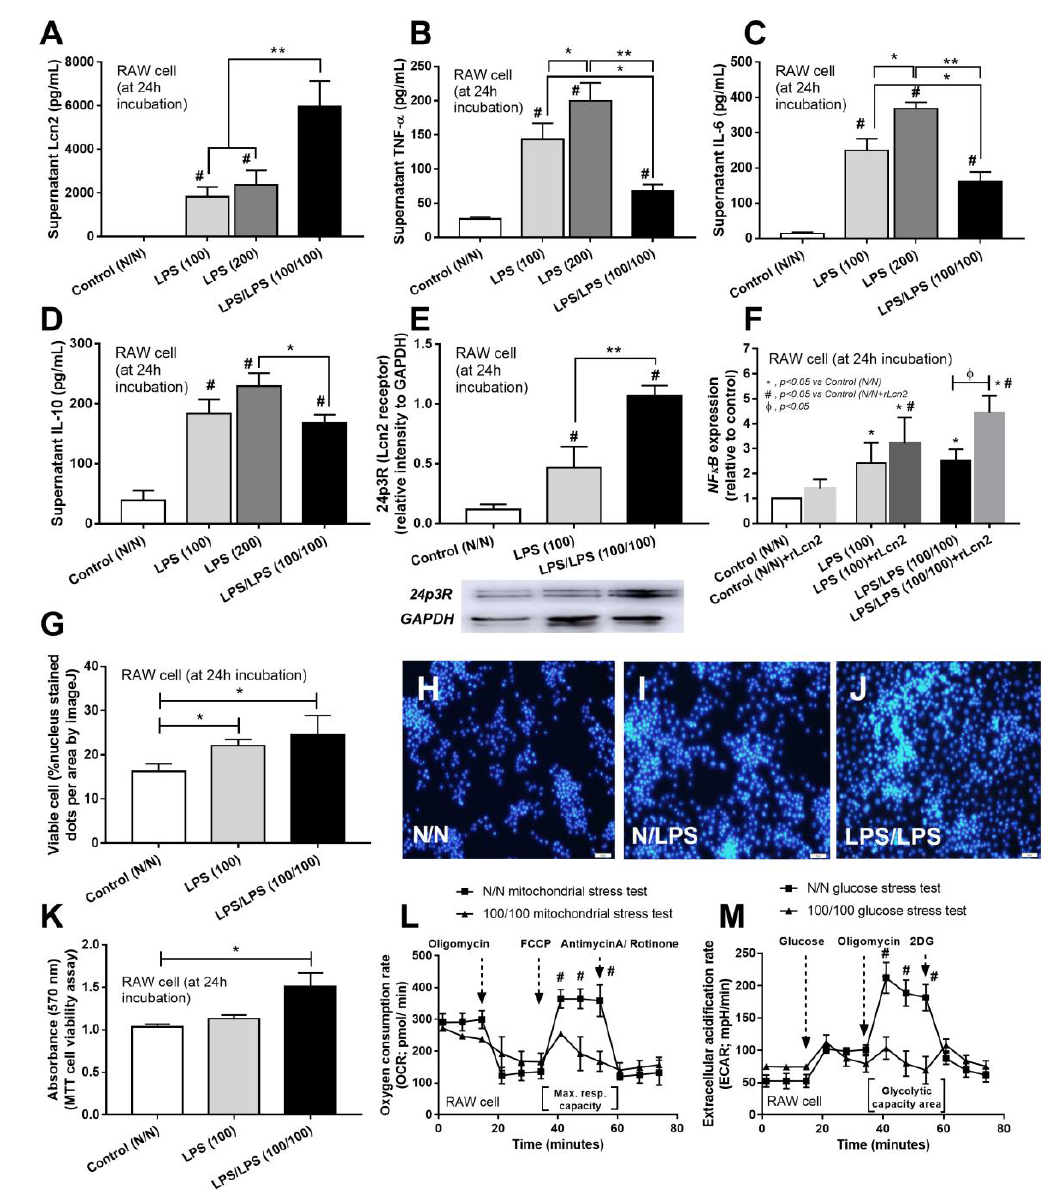
( B ). Additionally, pathway analysis clusters (DAVID) of up- and down-regulated proteins ( C , D ) and the enriched pathway of the proteins in LPS/LPS compared with the control ( E ) were demonstrated.